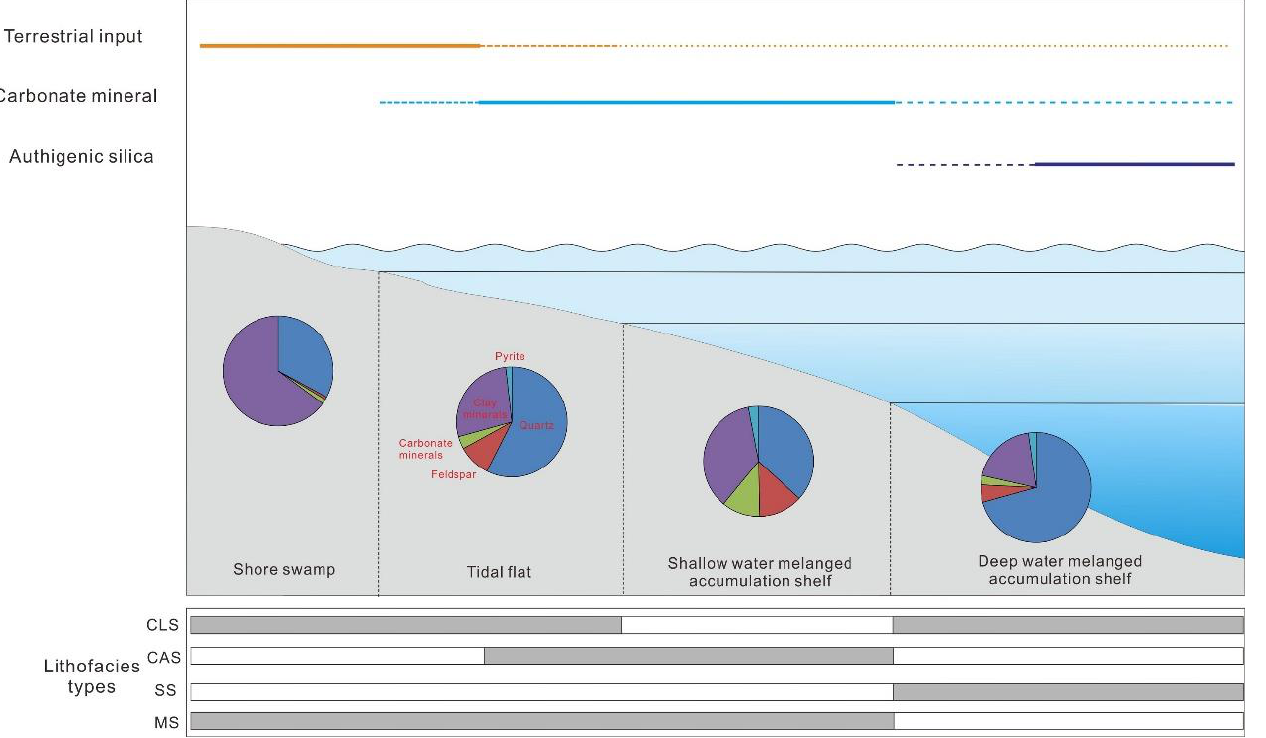
Figure 9. Depositional model of the Longtan Formation in the Sichuan Basin.